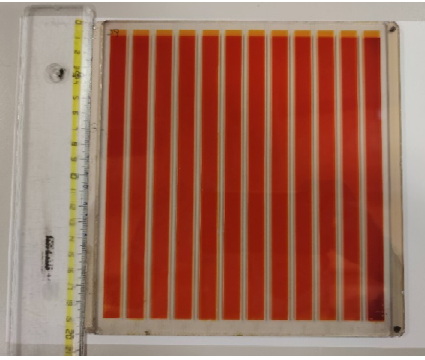
Figure 2. SEM image of the TiO 2 layer showing a 20 nm particle size.